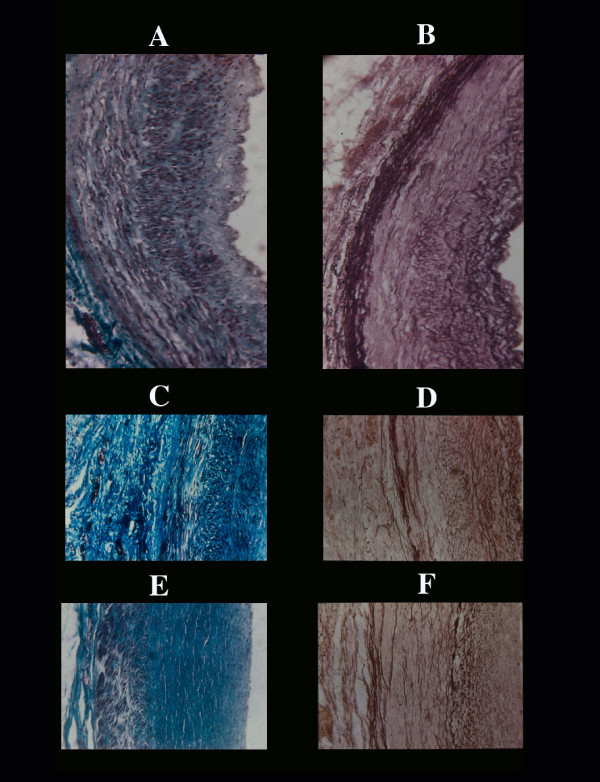
Coronary physiologic intimal thickening. This changes starts as nodular (already visible at birth at the site of vessel bifurcation) smooth muscle cells (A) and elastic fibrils (B) hyperplasia which in the second decade is diffuse to the whole intimal surface of all extramural arterial vessels. With aging there is a progressive increase of fibrous tissue which substitutes myo-elastic tissue (C, D) with final total, anelastic, fibrosis (E, F). Arteriosclerosis distinct from atherosclerosis